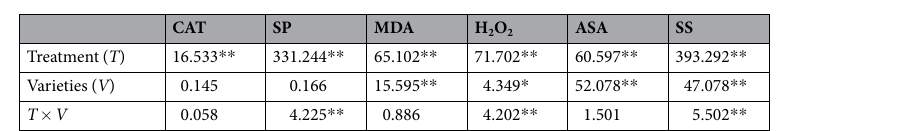
Figure 5. Histochemical localization of ⋅− O after three weeks drought stress. Dark blue deposits show insoluble formazan produced by the reaction of NBT with ⋅− O . 2